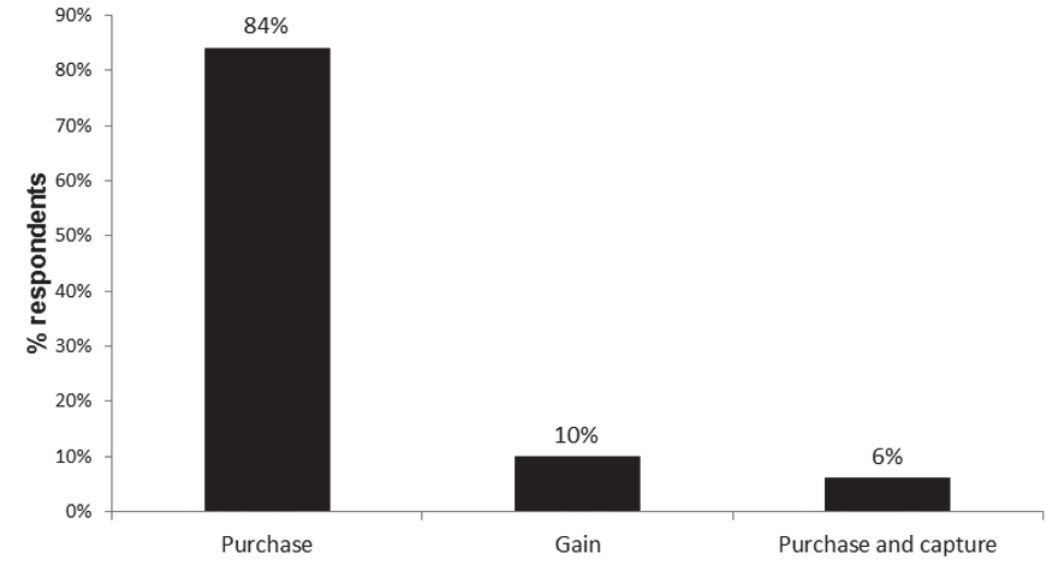
Figure 3 - The manners how pet birds were